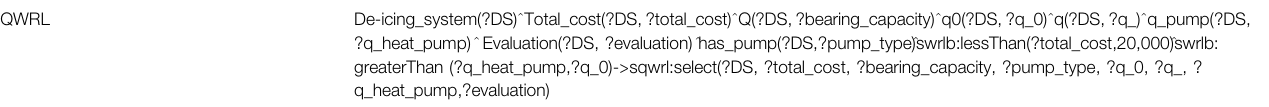
TABLE 10 | SQWRL rules to query feasible design solutions whose total cost is less than 20,000 RMB.